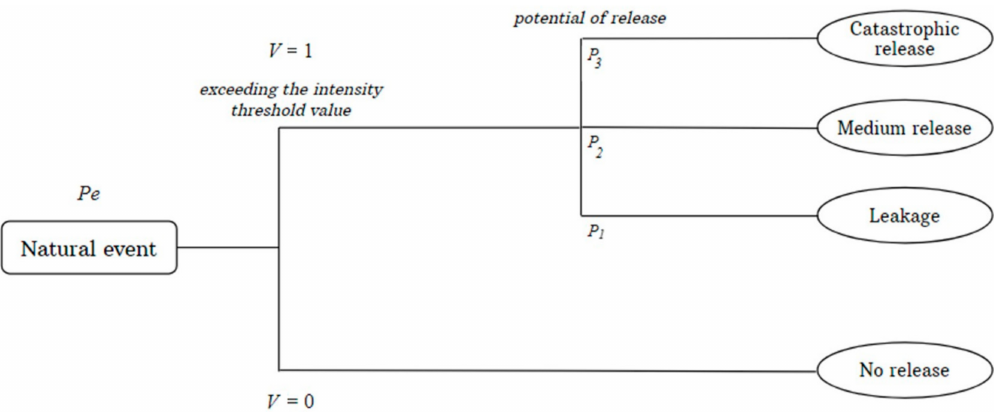
Figure 1. Sequence of events for the development of a Na-Tech